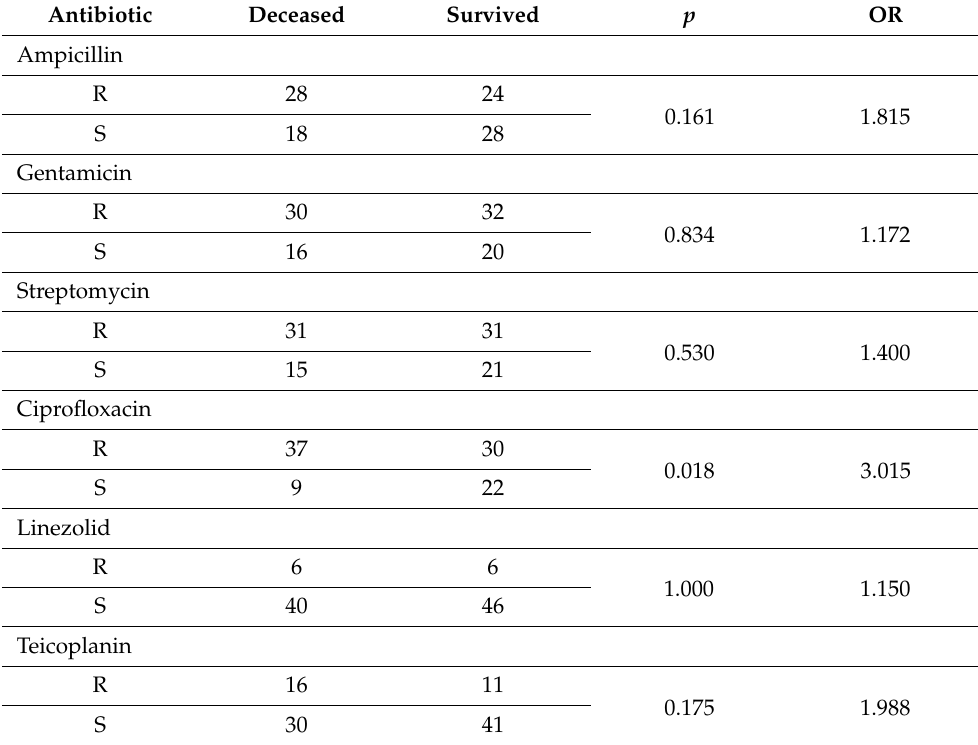
Table 11. Statistical analysis of the impact of antibiotic resistance on